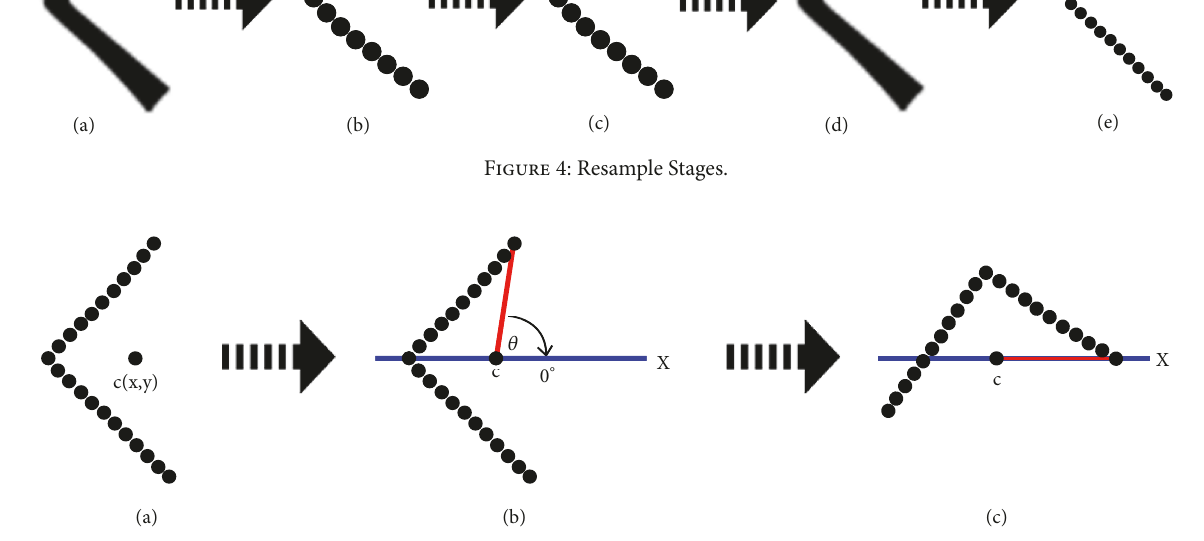
Figure 5: Rotation